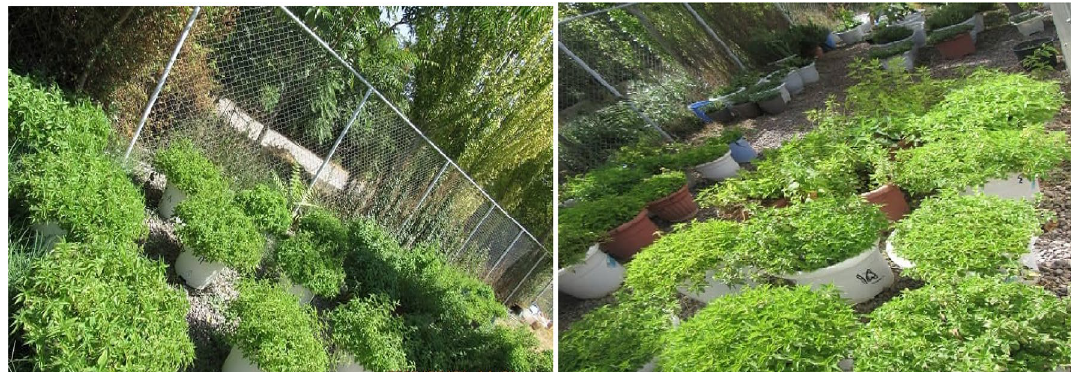
Figure 2. The Live Collection of Iranian Nettle (LCIN) is located at the Research Institute of Modern Biological Techniques, University of Zanjan, Zanjan, Iran, at latitude 36° 68 ′ N, longitude 48° 38 ′ E.